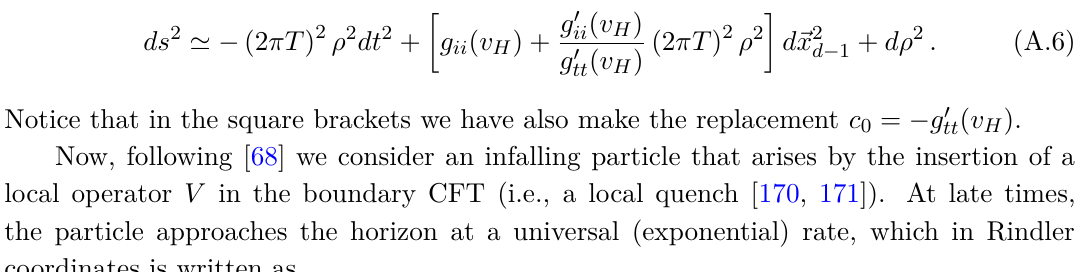
and t , with t . The smallest 1 2 2 > t 1 B t